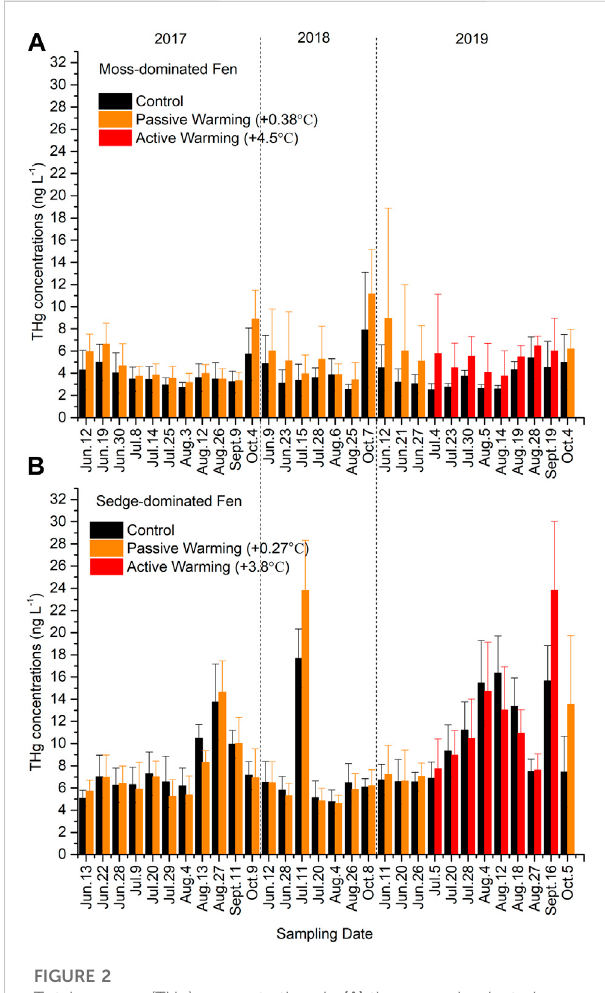
FIGURE 2 Total mercury (THg) concentrations in (A) the moss-dominated fen and (B) the sedge-dominated fen. Colors are different plot treatments: black for the control plots; orange for the passively warmed plots; red for the actively warmed plots. Bars are mean values and whiskers are ± ones tandard deviation. Note differences in y -axis